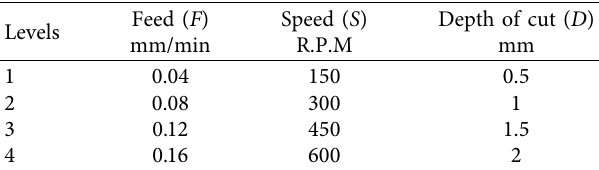
Table 6: Experimental turning